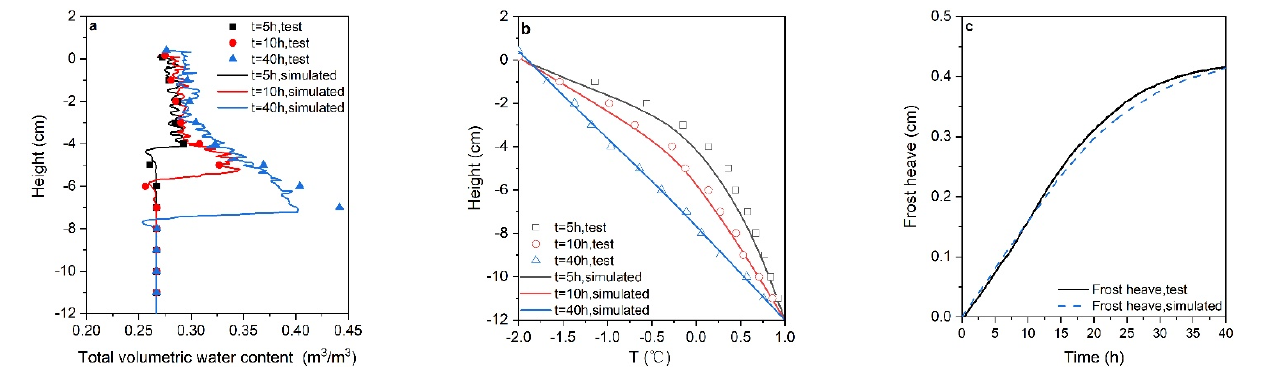
Figure 4. Comparison of the measured and simulated values of unfrozen water content, temperature, and frost heave in one-side freezing tests: ( a ) the total volumetric water content at different moments, ( b ) the temperature at different moments, and ( c ) the variations in the frost heave.